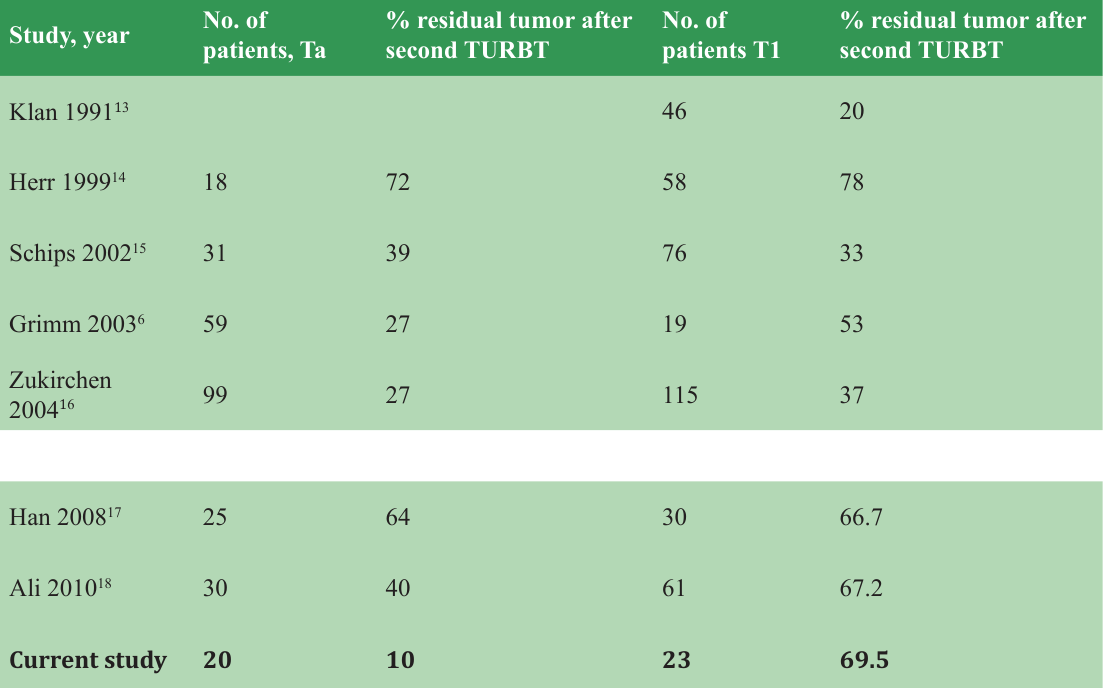
Table 4: Studies showing rate of residual tumor after second TURBT for Ta and T1 No. of % residual tumor after Study, year patients, Ta second TURBT